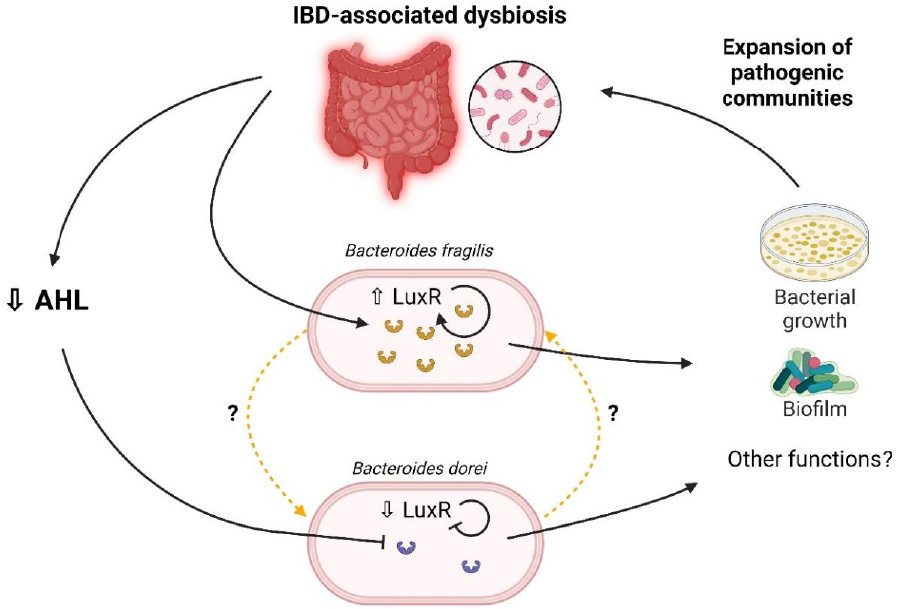
Figure 6. Impact of IBD-associated dysbiosis on LuxR receptors. Created with https://BioRender.com (accessed on 26 October 2022).